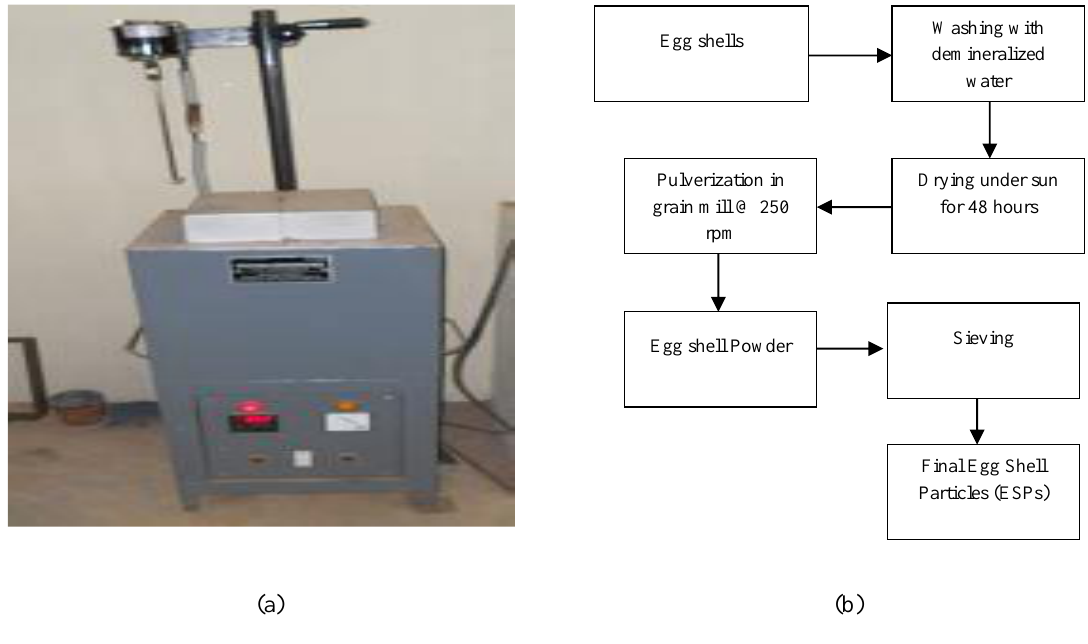
Fig.3. (a) Electric furnace and (b) Process flow